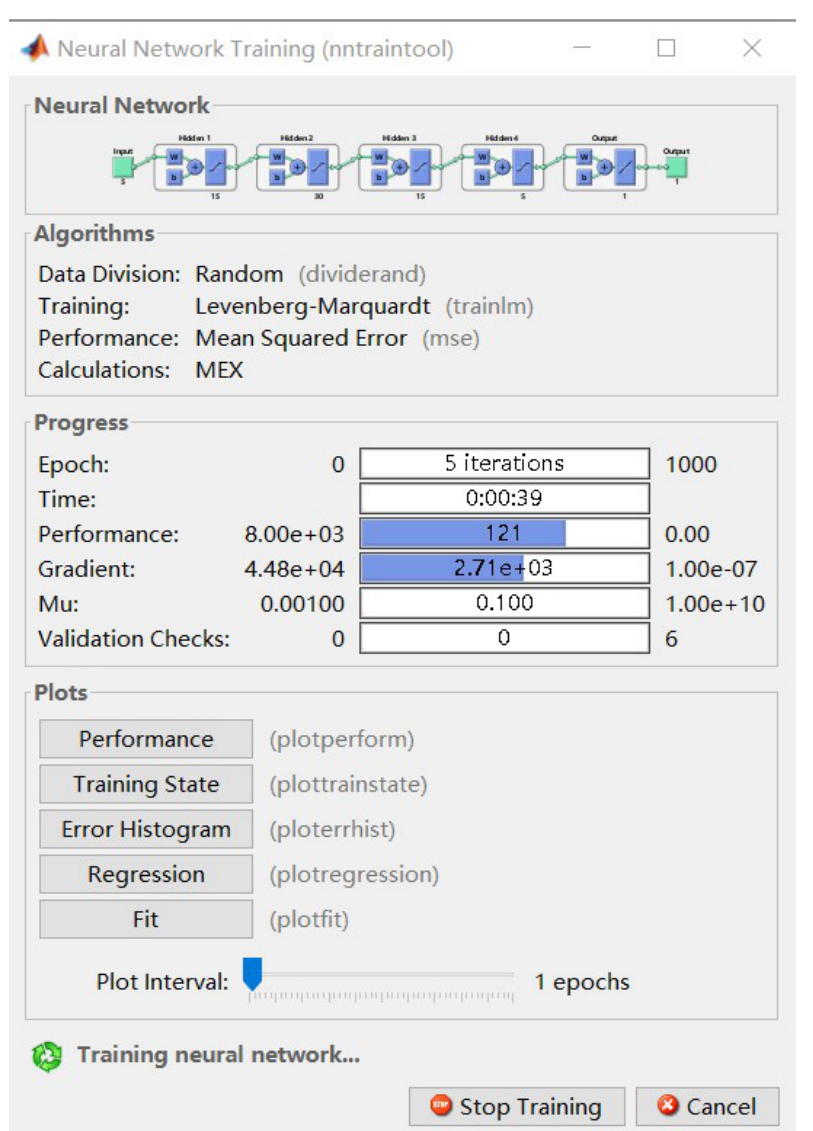
Figure 11. The final structure of the ANN.